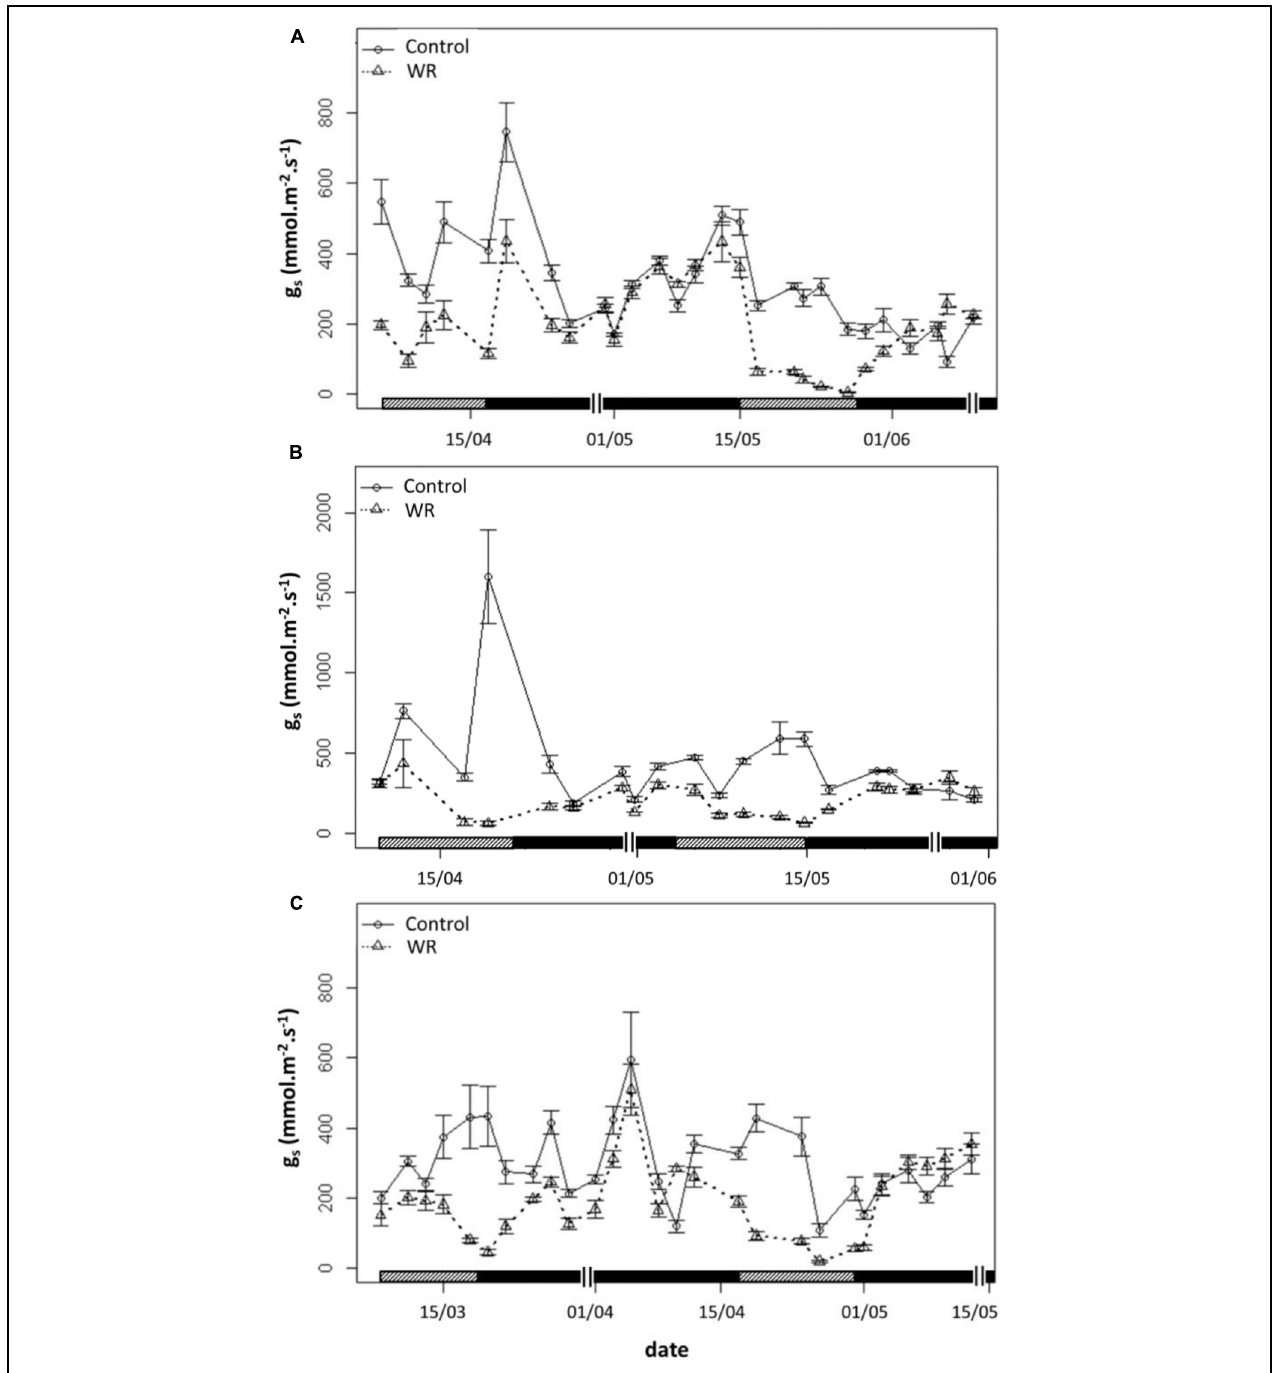
FIGURE 5 | Stomatal conductance (g s ) during water restriction (WRP) and re-watering (WWP) periods. All measurements were carried out on the two youngest leaves completely developed of control plants ( ) and plants subjected to a WR treatment ( ) for the three genotypes ‘Baipome’ (A) . ‘The